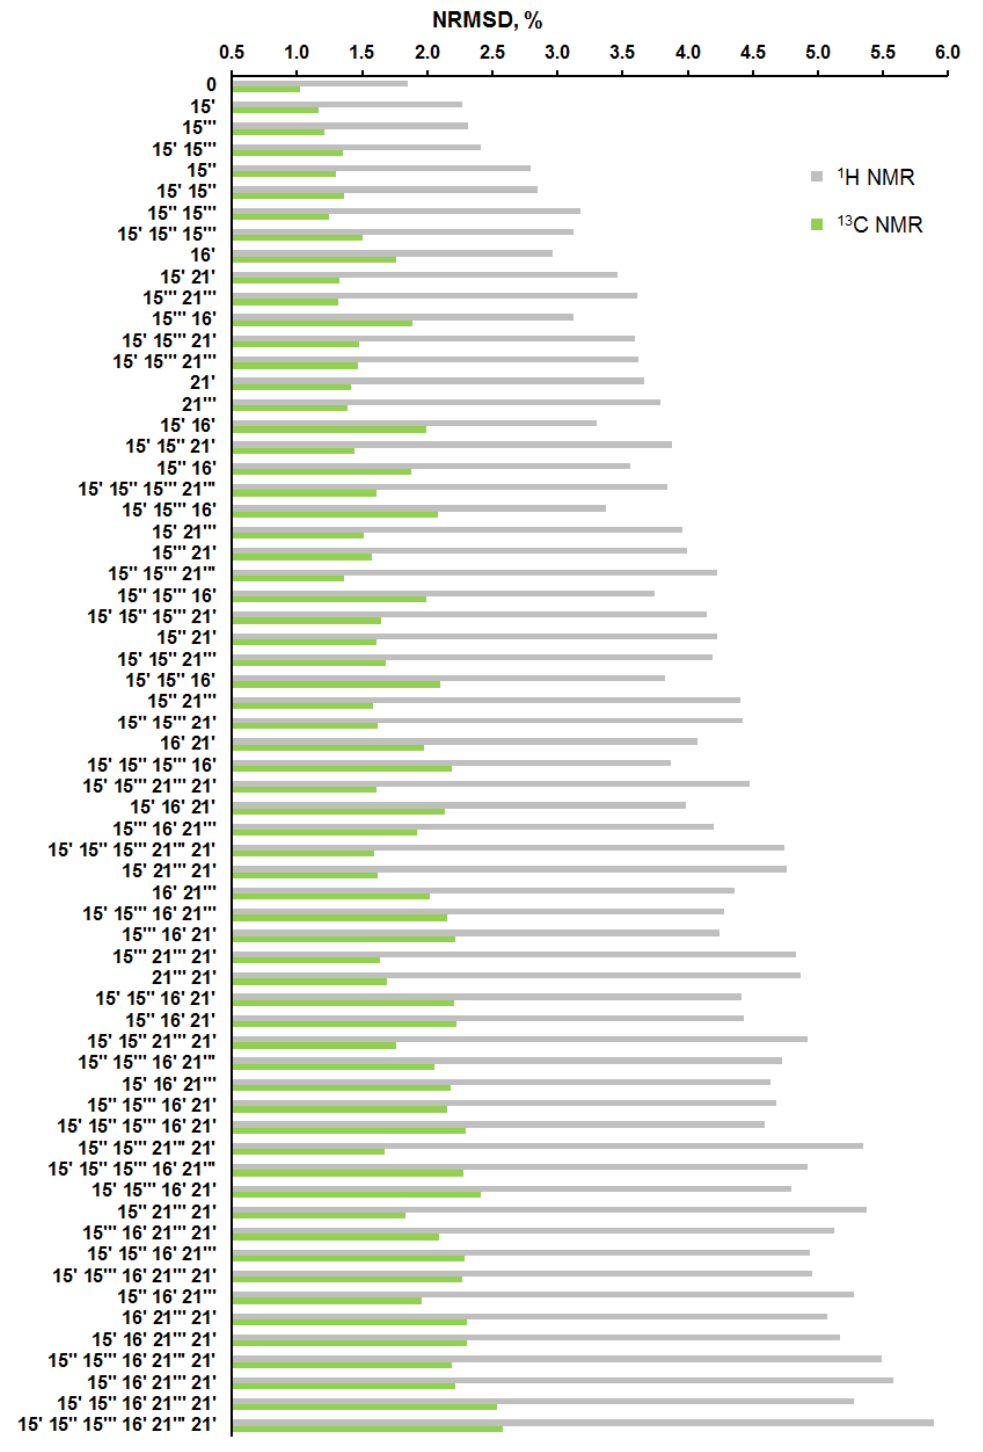
Figure 9. Distribution of the normalized RMSD values (%) of 64 alternate diastereomers of alasmontamine A.